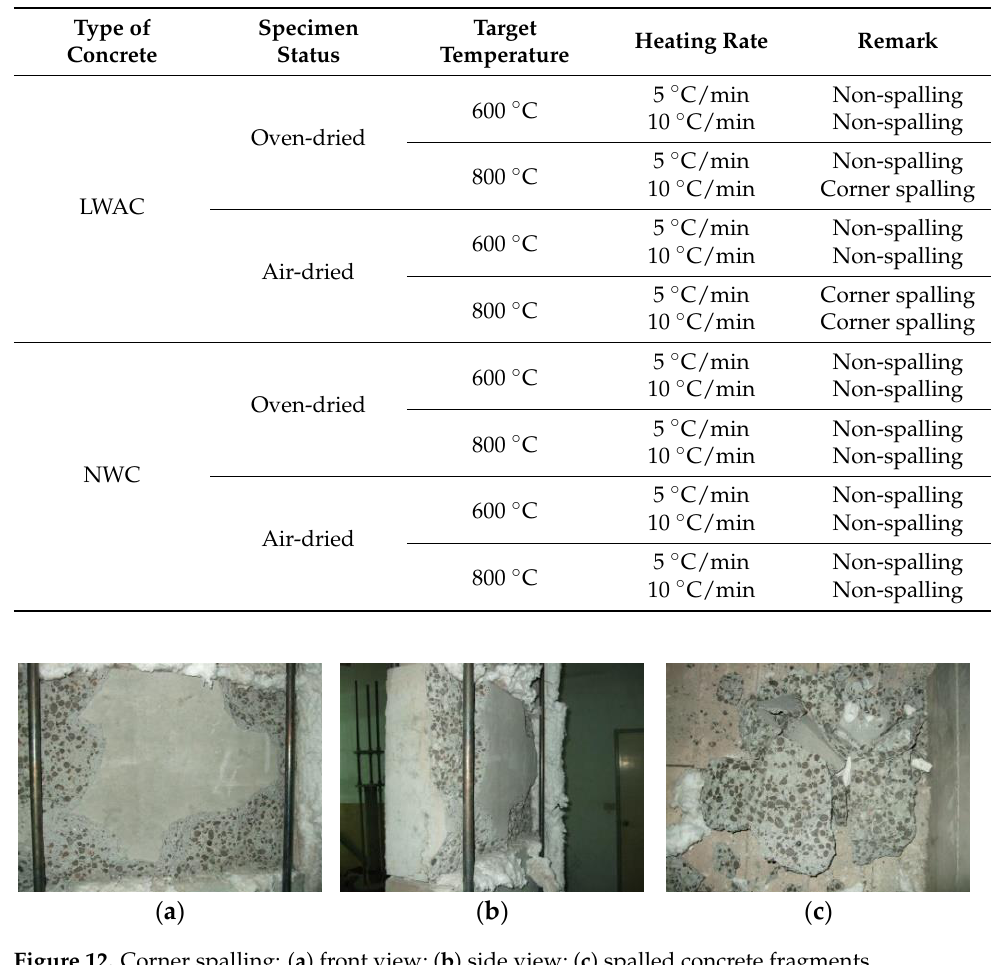
Figure 12. Corner spalling: ( a ) front view; ( b ) side view; ( c ) spalled concrete fragments. Table 6. High-temperature test results.